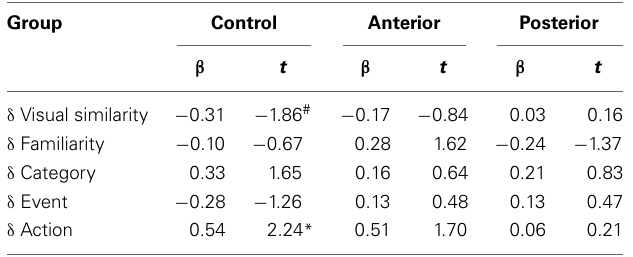
Table 4 | Coefficients of Step 3 model for Th + A vs. Th-A triads; groups defined by lesion loci.